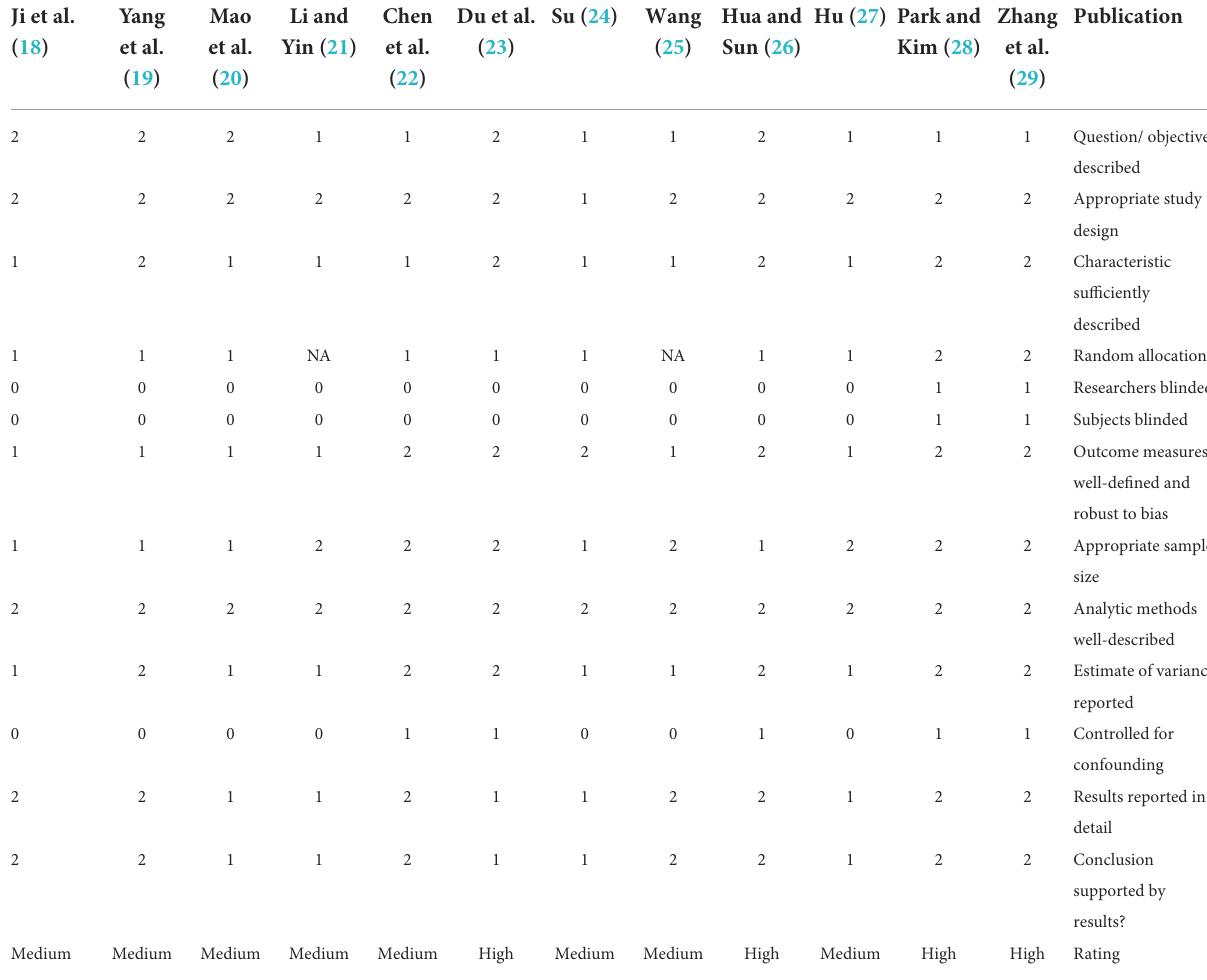
TABLE 3 “Qualsyst” of quality